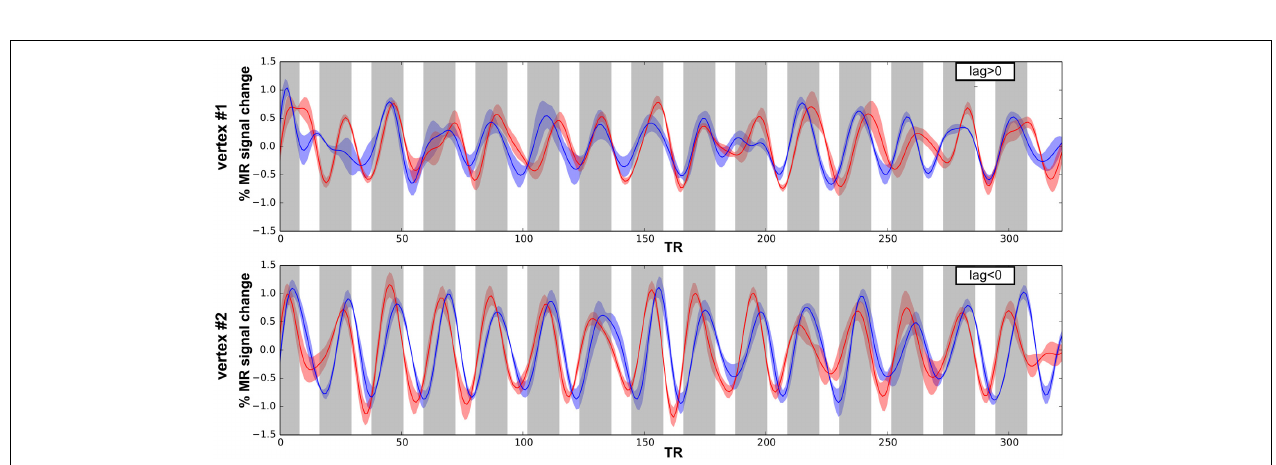
represent main folding. CS: Circular sulcus is indicated with dashed white lines. (B) Activations to sounds as compared to silent baseline. SPM t-maps (volumes) are projected onto the surfaces. Statistical maps are thresholded at p < 0 . 001 uncorrected for multiple comparison.